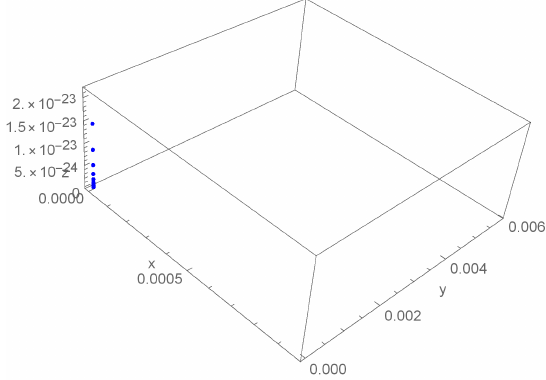
Figure 20. Attractor of system ( 3 ) in 3D when α = 0.5, β = 1.7, γ = 1.6, δ = 0.3, ζ = 0.7, η = 1.6, µ = 2.7, ε = 0.6, υ = 0.8, ρ = 1.11, σ = 1.11, ω = 0.2. with initial conditions x 0 = 0.002, y 0 = 0.0084 and z 0 = 0.0003.